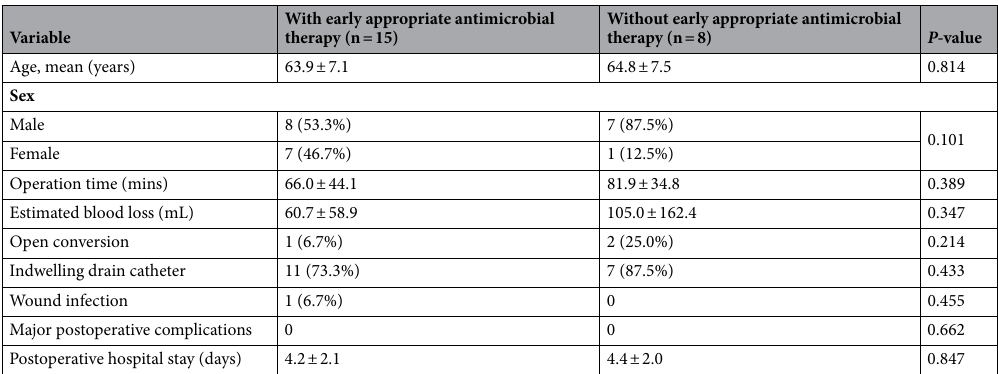
Table 2. Comparative analysis of the perioperative outcomes in grade I acute cholecystitis patients with and without early appropriate antimicrobial therapy in recent period. Data are presented as the mean ± standard deviations or numbers with percentages in parentheses unless otherwise